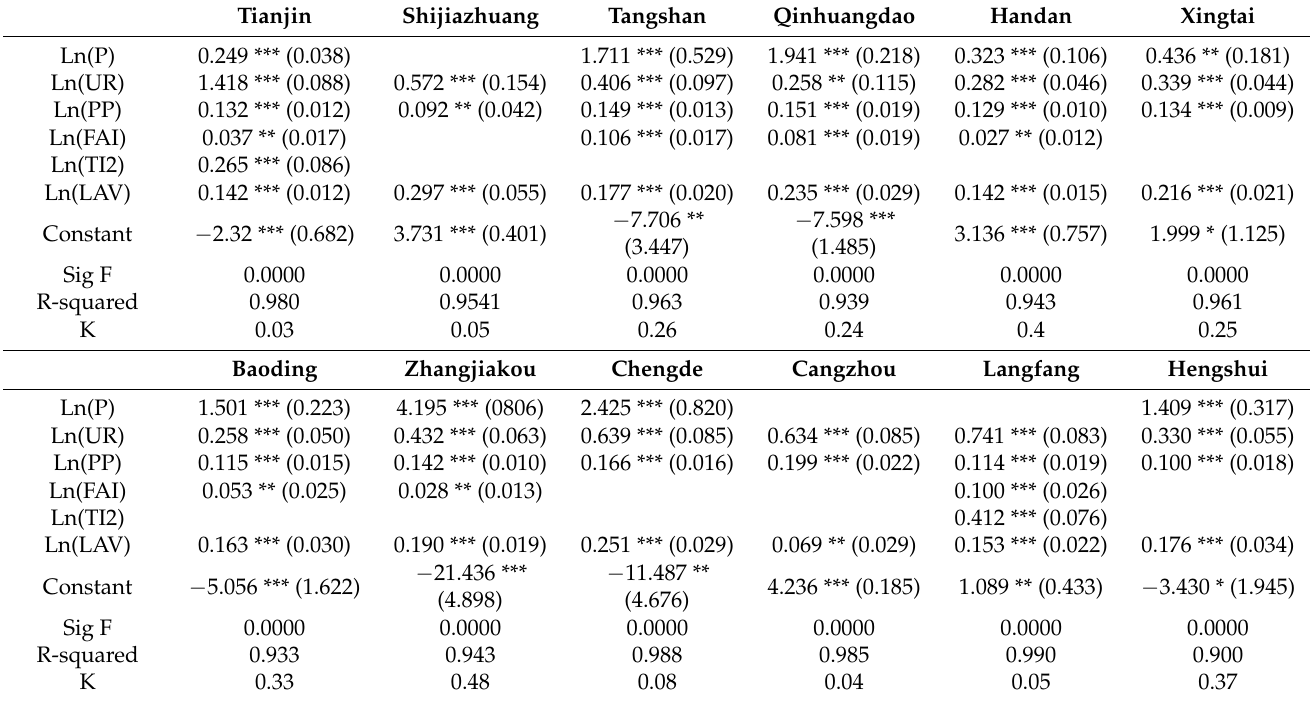
Table 6. Ridge regression estimation results of